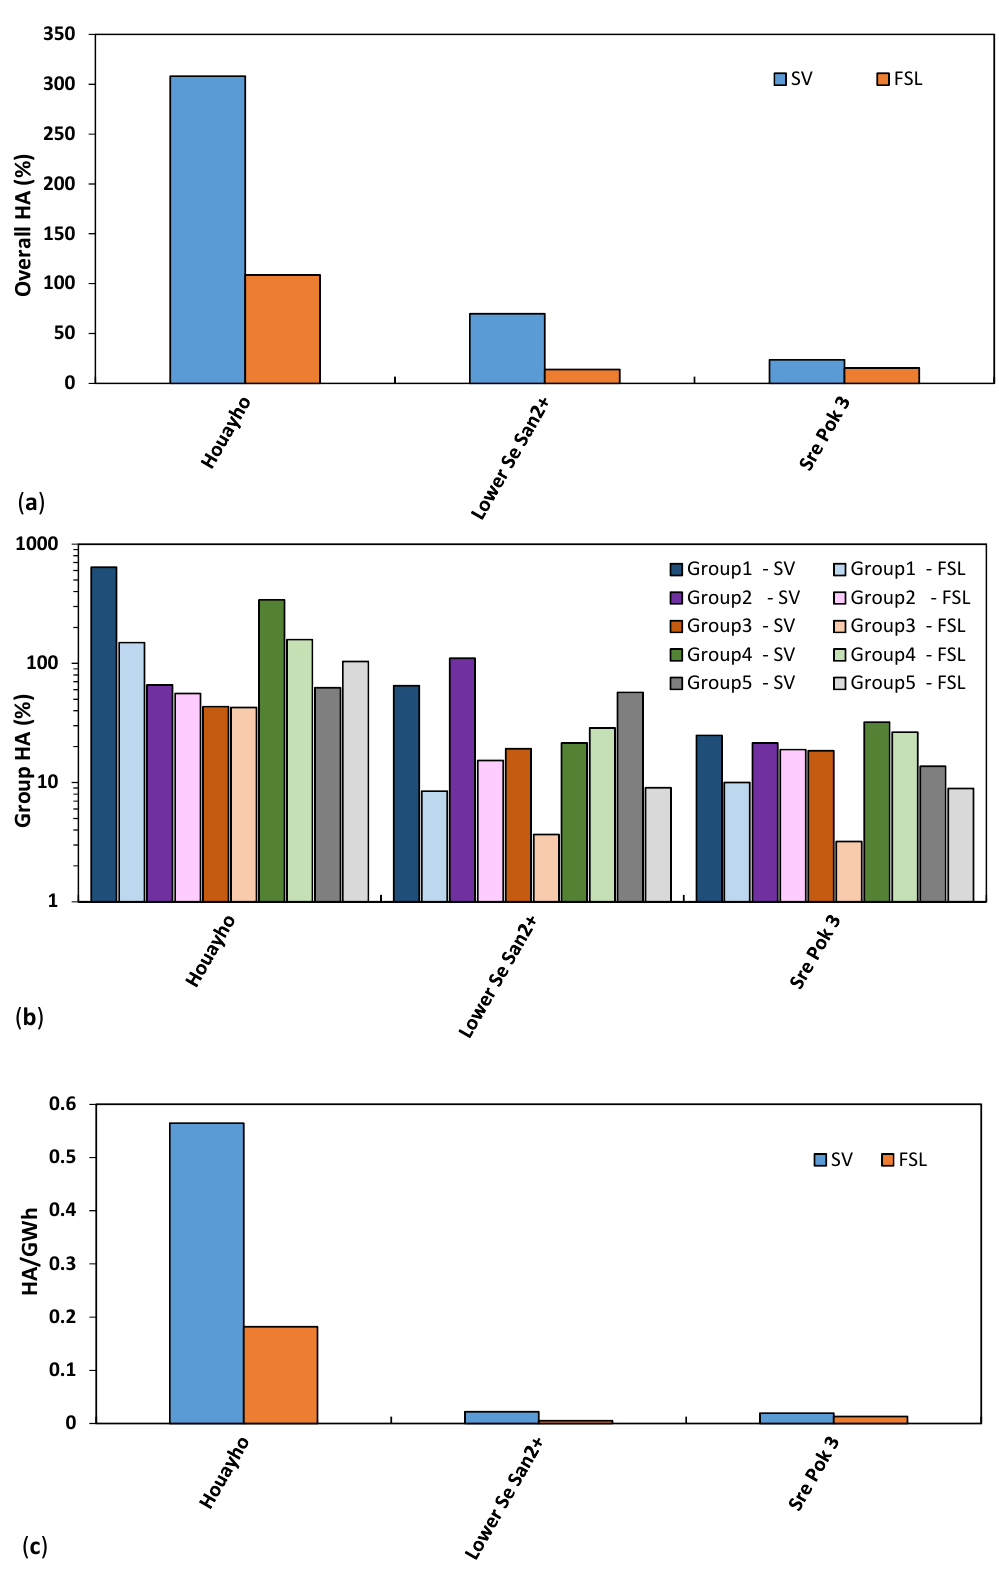
Figure 8. ( a ) Overall HA (%) and ( b ) HA for each IHA statistics group (% in log scale) due to operation of hydropower reservoirs at downstream of each reservoir, and ( c ) HA per gigawatt-hour of hydropower reservoirs under the seasonal variation and full supply level rule curve (denoted by SV and FSL respectively) for the baseline climate (BLR) scenarios.